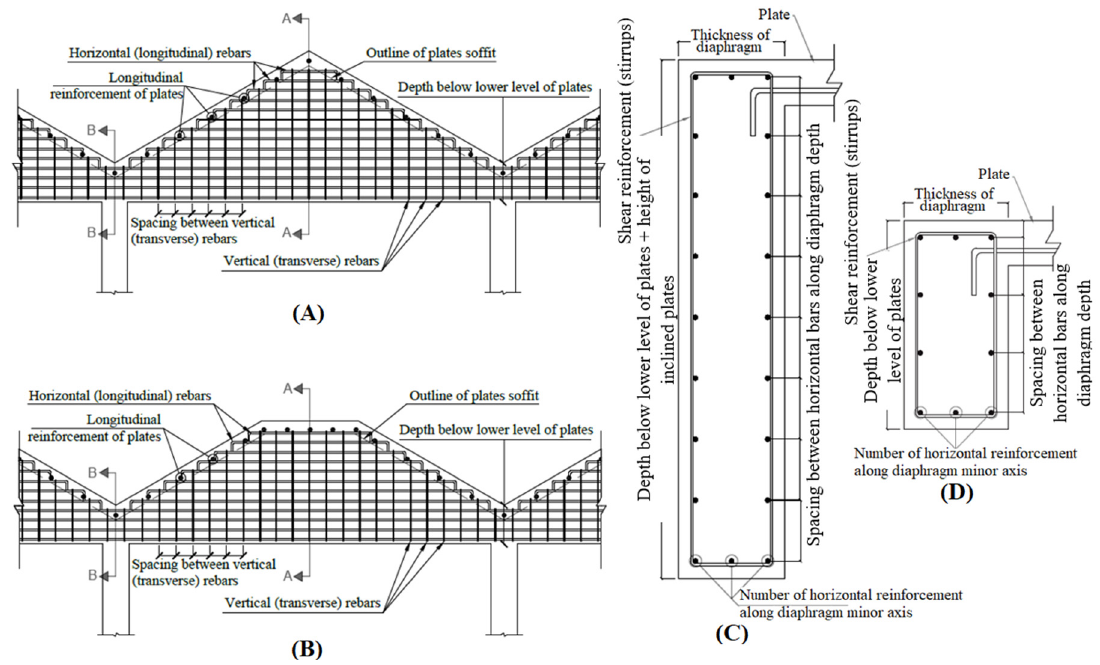
Figure 5. Diaphragms controlling design variables (V 10 ): ( A ) Elevation view of diaphragms in “V” type folded plates roofed building; ( B ) Elevation view of diaphragms in three-segment type folded plates roofed buildings; ( C ) Section A-A view; ( D ) Section B-B view.